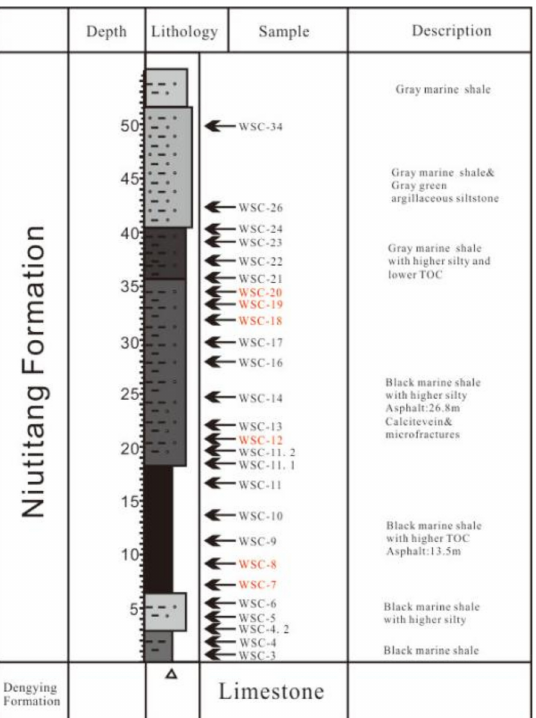
Figure 1. The column chart of sampled lithology in Wenshuicun section, Guizhou province. (Notice: the sample marked red is the sample used in this